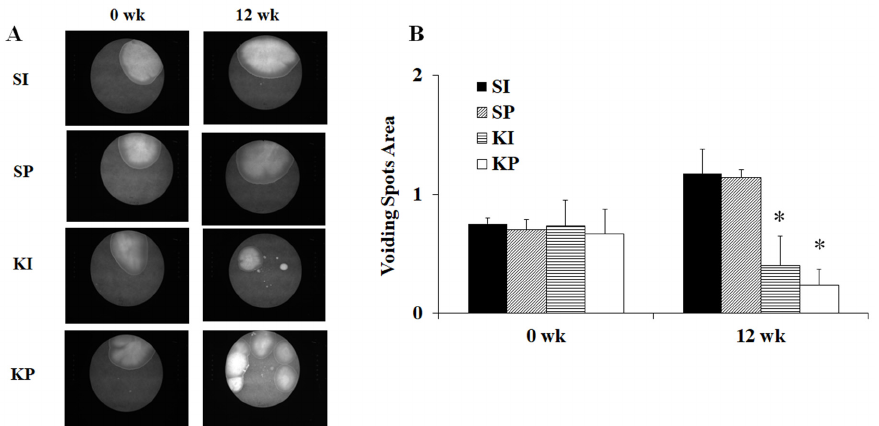
Figure 4. The effect of ketamine on micturition. When compared to SI and SP mice, KI and KP mice had more urine spots but smaller urine spots size ( A ). The voiding spots area of KI and KP mice had significantly decreased after 12 weeks of ketamine treatment ( p < 0.05) ( B ). The values are expressed in means ± SD. An asterisk indicates a significant difference in Bonferroni post-tests following one-way ANOVA ( p < 0.05).